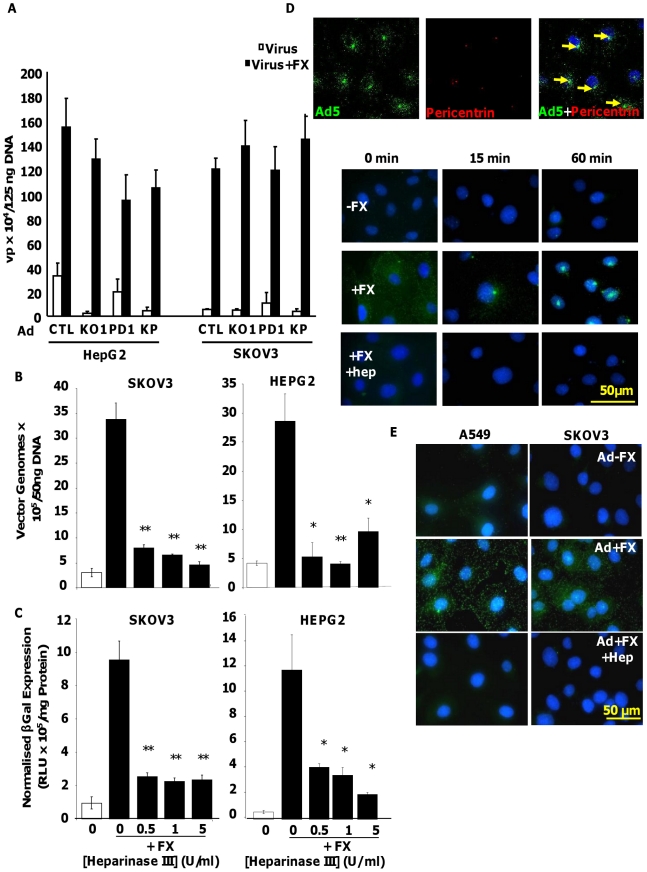
Importance of HS sidechains during Ad5 binding, cell entry, cytosolic transport and transduction in vitro.(A) Binding of 1000 vp/cell Ad5CTL, Ad5KO1(CAR-binding mutant), Ad5PD1 (αv integrin-binding mutant) or Ad5KP(CAR- and αv integrin-binding mutant) particles to cells was quantified after incubation of Ad particles with HepG2 or SKOV3 cells for 1 h at 4°C in the presence or absence of 10 µg/ml FX. Vector genomes were detected by quantitative PCR. (B+C) SKOV3 (left panels) or HepG2 (right panels) cells were incubated for 1 hour at 37°C in serum free media containing 0–5 U/ml of Heparinase III. The effect of heparinase pre-treatment on FX-mediated Ad5 binding (1000 vp/cell, 1 hour, 4°C) (B) or Ad5 mediated transduction (1000 vp/cell, 3 hours, 37°C) was quantified (C). ** = p<0.01. (D) (upper panel) 10,000 vp/cell of Alexa488-labelled Ad5 (green) were allowed to bind cells for 1 h at 4°C, then incubated at 37°C for 60 min prior to fixation and staining for the MTOC marker pericentrin (red). Nuclei were counterstained using DAPI. Colocalisation of fluorescently-labelled Ad5 particles with pericentrin is indicated by the yellow arrows. Images were captured on a confocal microscope under a 63× objective (D) (lower panel) Alexa-labelled Ad5 was allowed to bind cells for 1 h at 4°C in the presence or absence of 10 µg/ml FX and/or heparin (Hep). Cells were then incubated at 37°C for 0 min to 60 min prior to fixation. Nuclei were counterstained using DAPI. (E) Fluorescently-labelled Ad5 was allowed to bind cells for 1 h at 4°C in the presence or absence of 10 µg/ml FX and heparin (Hep). Nuclei were counterstained using DAPI. Images were captured under a 40× objective.